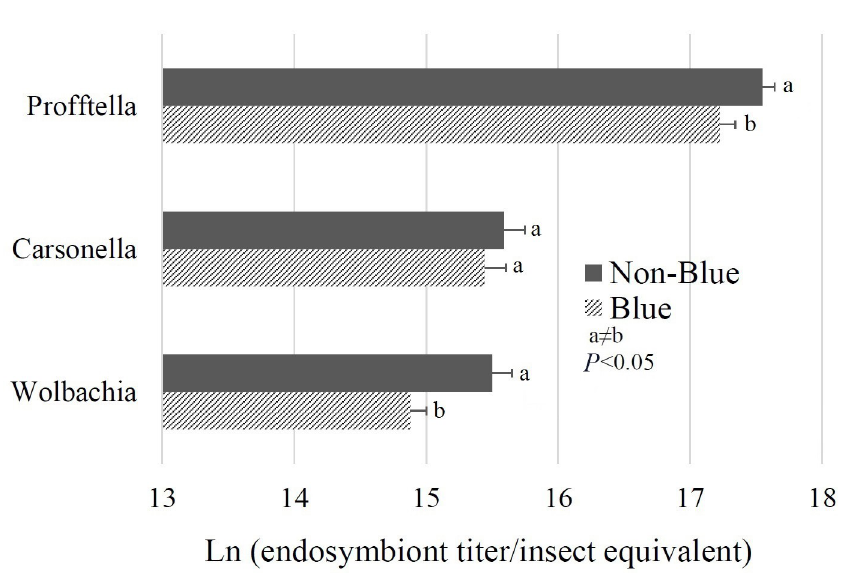
Fig 3. The titer of the bacterial endosymbionts Profftella , Carsonella , and Wolbachia in C Las-non-exposed, blue and non-blue adult D . citri , represented as natural logarithm (endosymbiont titer/insect equivalent). Titer of Profftella and Wolbachia were higher in non-blue D . citri as compared to blue D . citri (P < 0.05, n = 10 biological replicates).